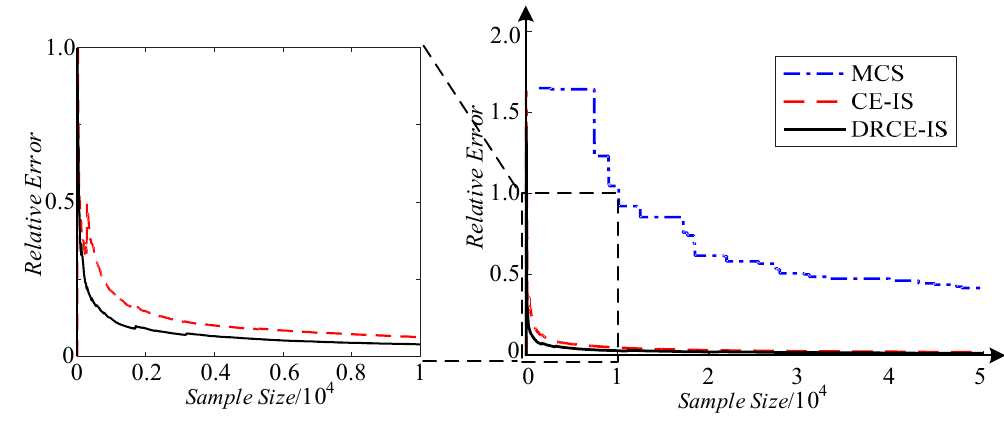
Figure 7. The convergence of the three methods.